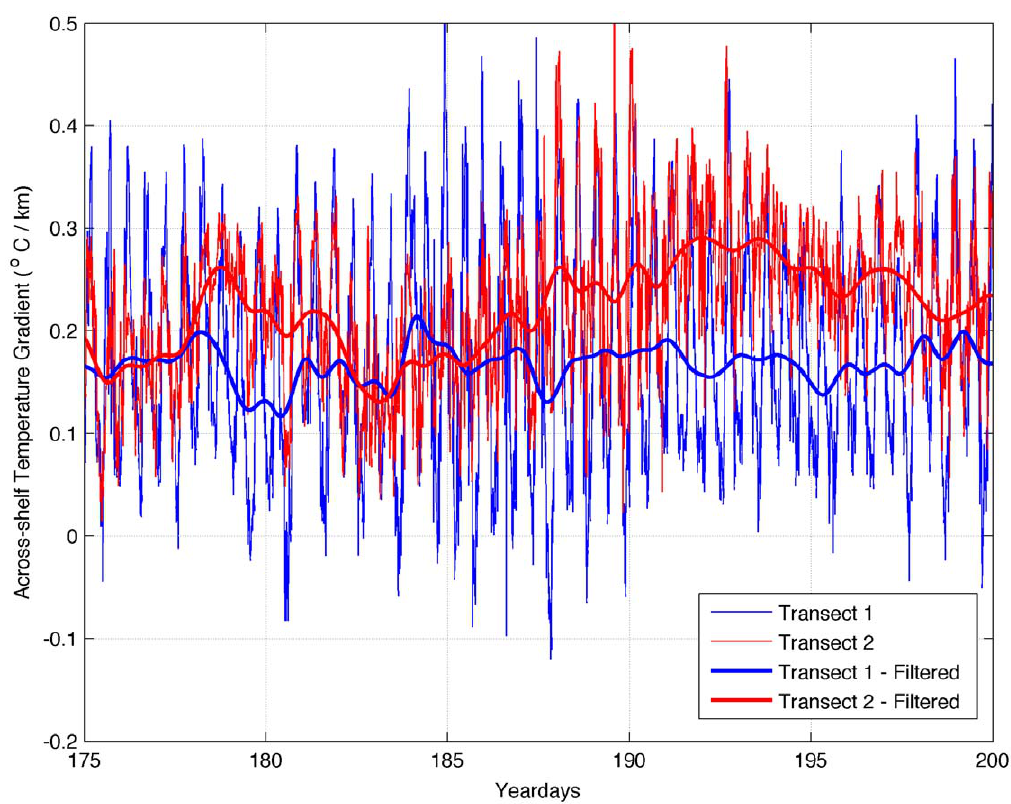
Figure 11. Across-shelf gradient of temperature ( 6 C/km) along transects 1 (blue line) and 2 (red line). Thin lines are unfiltered temperature. Thick lines have been filtered with a Lanczos filter with a 1/36 hr 2 1 cut off frequency.